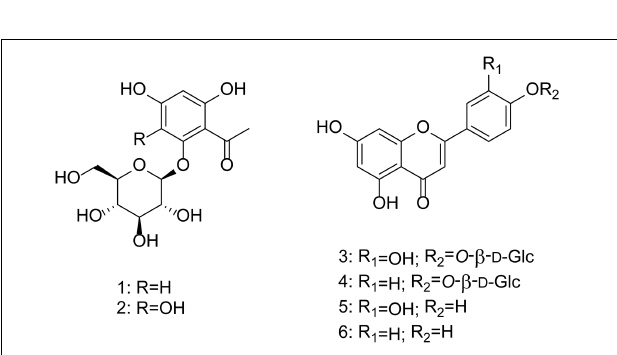
FIGURE 2 | Compounds identified from Lawsonia inermis L. leaves